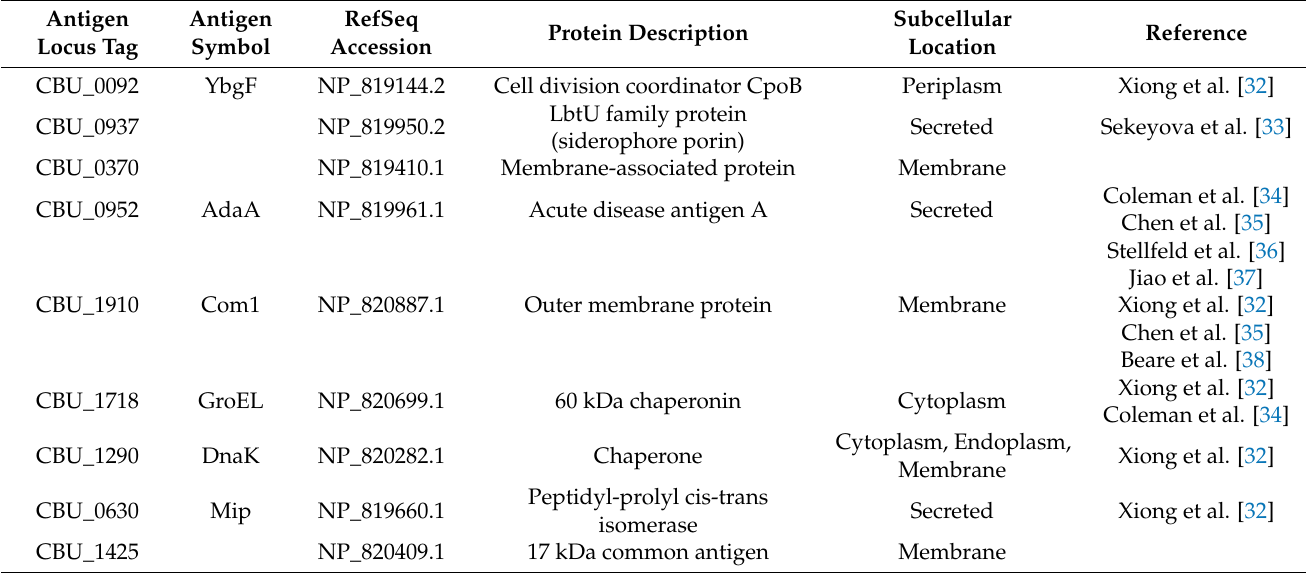
Table 1. C. burnetii proteins selected as target antigens for the multiplex serology